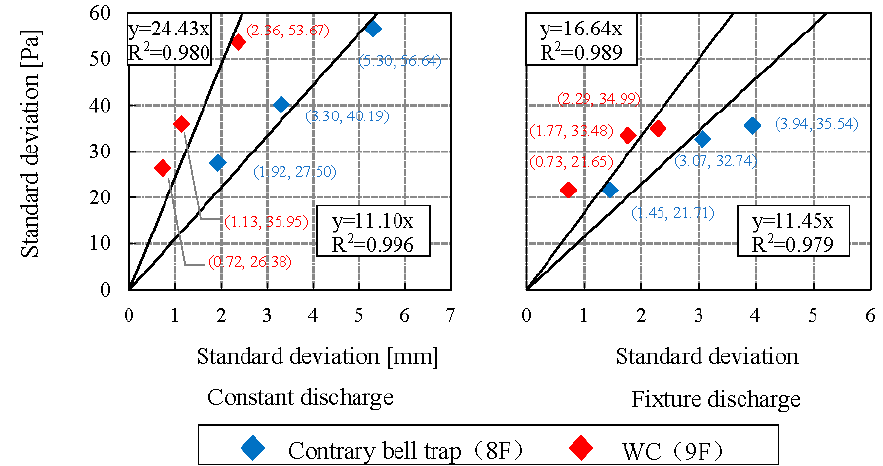
Figure 7. SD of seal water fluctuation. Figure 7 . SD of seal water fluctuation. Figure 7 . SD of seal water fluctuation.